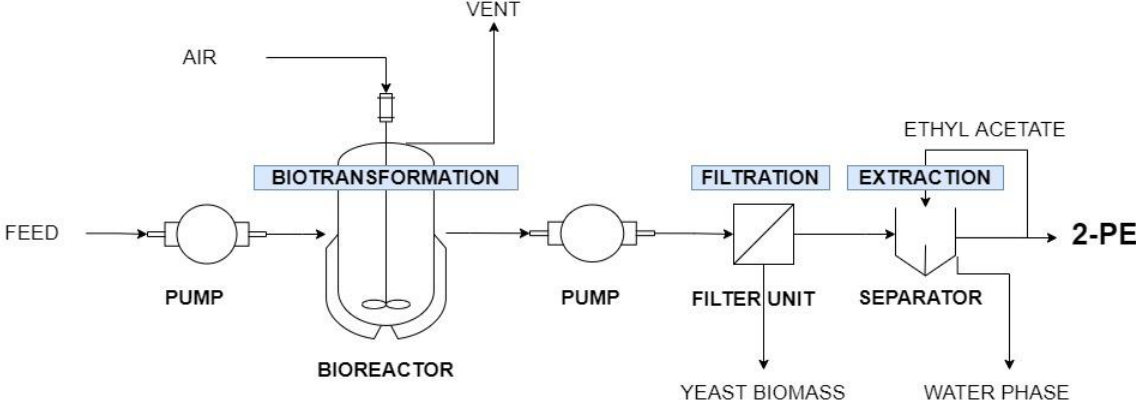
Figure 2. Schematic representation of continuous system for 2-PE bioproduction and its recovery from fermentation broth.